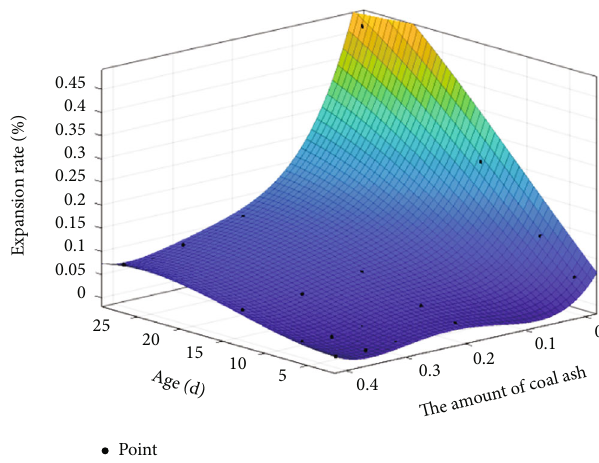
Figure 14: Quartic fi tting diagram of coal ash content, age, and expansion rate (cement alkali content 2.0%).